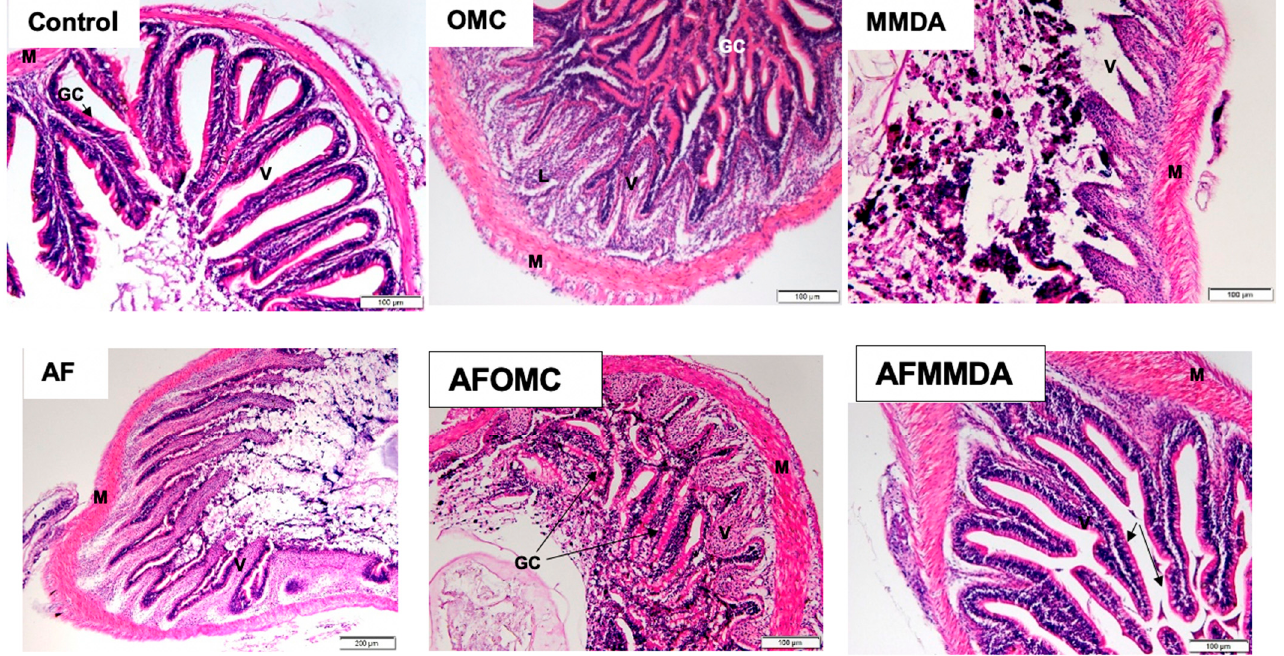
Figure 4. Histopathological view of the intestine of control and treated groups; control shows apparently normal structures of villi; OMC had atrophy and necrosis of villi; MMDA showed atrophy and necrosis of villi; AF shows necrosis of villi; AFOMC had atrophy and necrosis of villi and AFMMDA had normal structure of villi. M = Muscle layer, GC = Goblet cells, V = Villi.